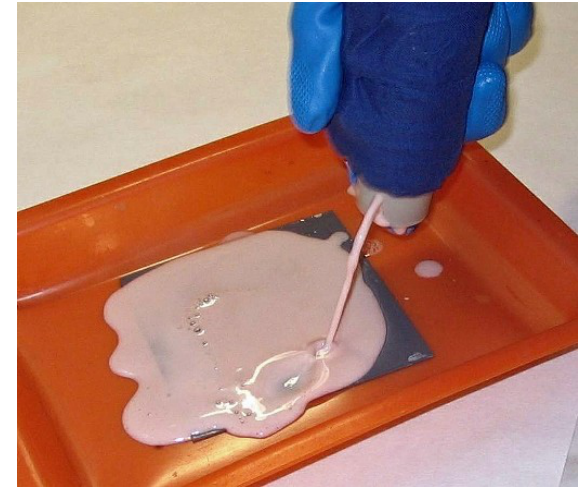
Figure 4. Decontamination of surfaces by the Hvezda two-chamber foam